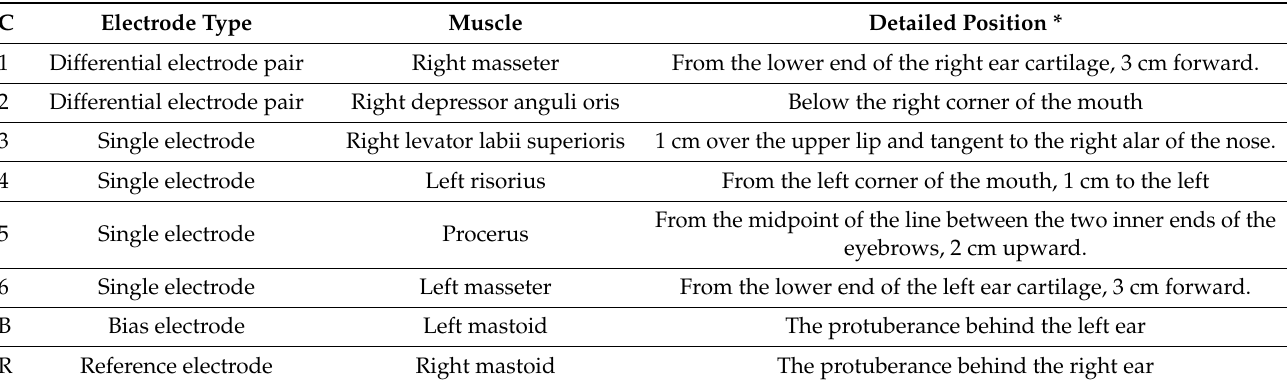
Table 1. Detailed electrode positions.